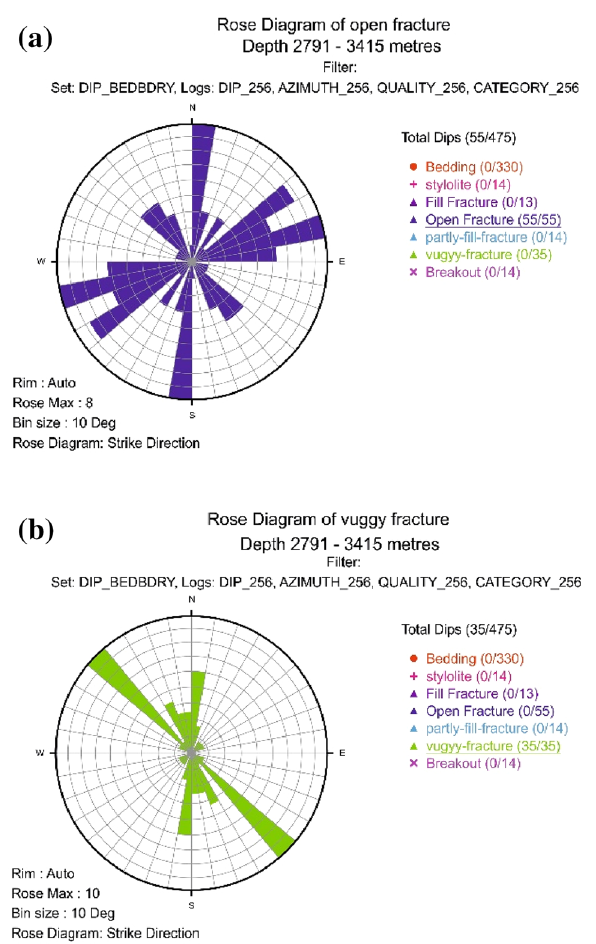
Fig. 6 Rose diagram of open fractures ( a ) and vuggy fractures ( b )